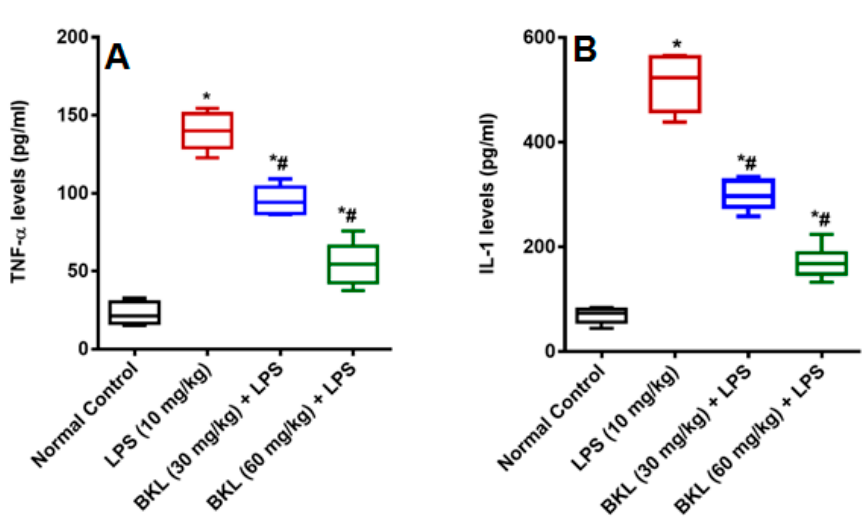
Figure 3. Effect of bakuchiol on LPS-induced proinflammatory cytokines ( A ) TNF- α , and ( B ) IL-1 α (pg / mL). Results are represented as mean ± SEM of six rats / group. * p < 0.05 vs. control; # p < 0.05 vs. LPS group.